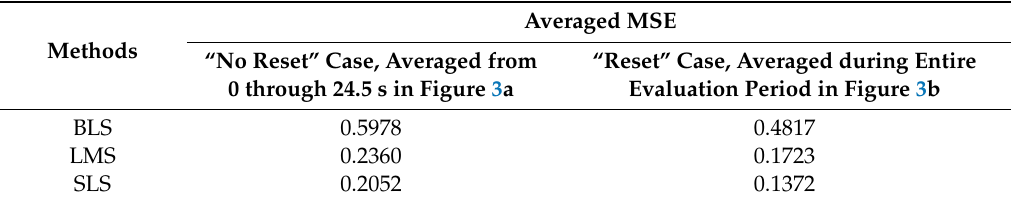
Table 1. Averaged